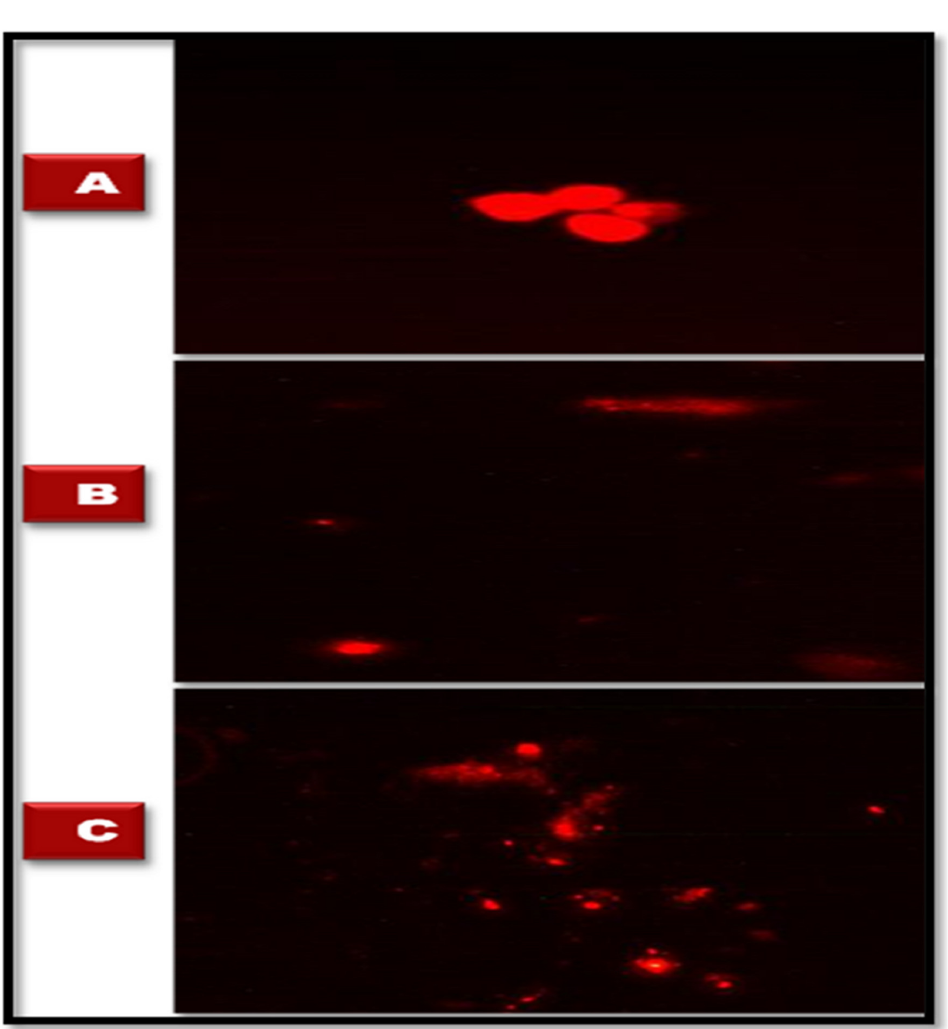
Figure 9. Ranks of comet according to the percent of DNA in the tail. ( A ) Control group, ( B ) B. alexandrina snails after exposure to LC 10 of SeNPs (31.826 mg/L), ( C ) adult B. alexandrina snails after exposure to LC 25 of SeNPs (44.15 mg/L).